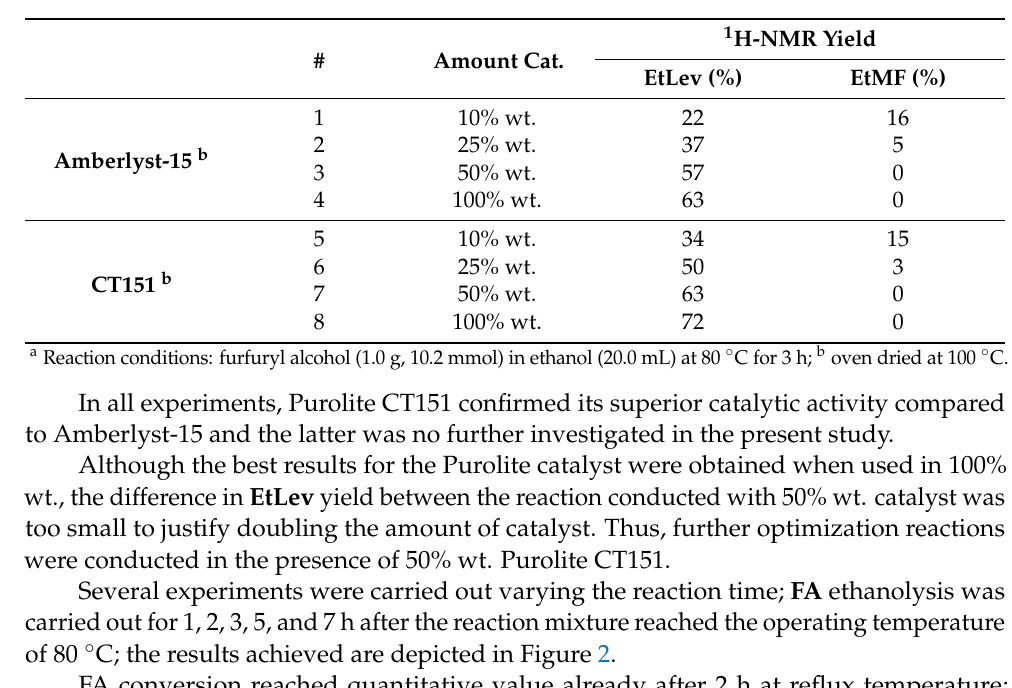
Table 2. Synthesis of EtLev in presence of different amount of Purolite CT151 and Amberlyst-15 a . 1 H-NMR Yield # Amount Cat. EtLev (%) EtMF (%) 1 10% wt. 22 16 2 25% wt. 37 Amberlyst-15 b